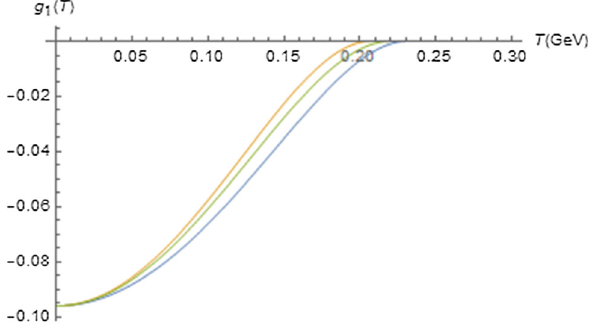
Fig. 2 g 1 ( T ) term at N f = 2, F = 87 MeV (green line); N f = 3, F = 100 MeV (blue line); N f = 5, F = 140 MeV (orange line)